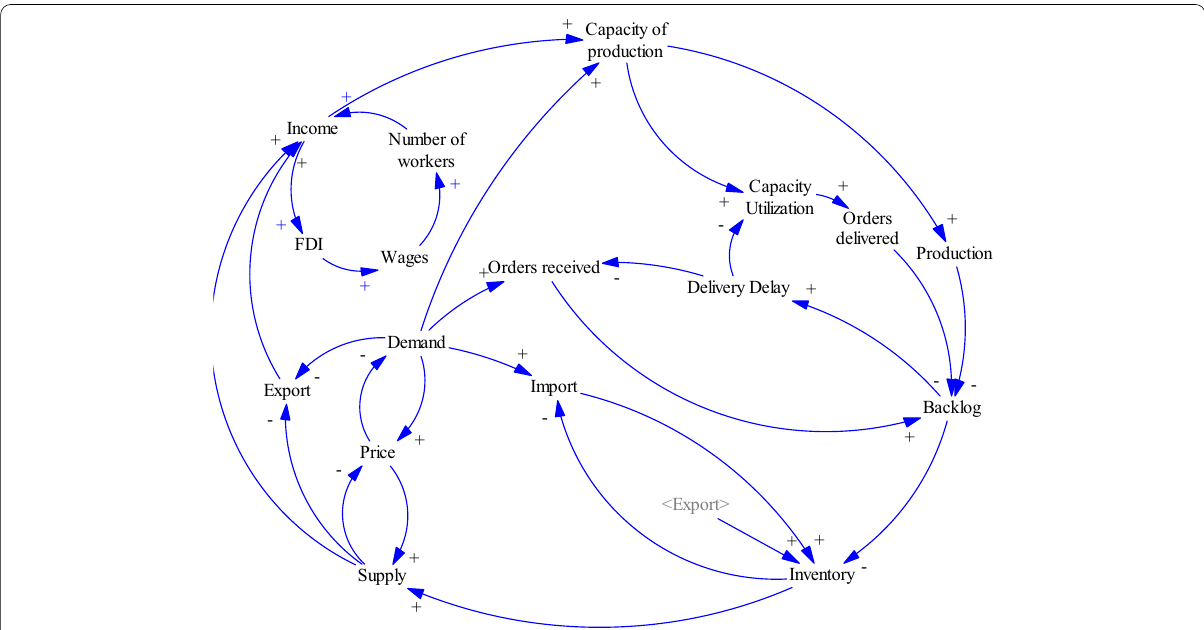
Fig. 6 Relationships of order related variables with other